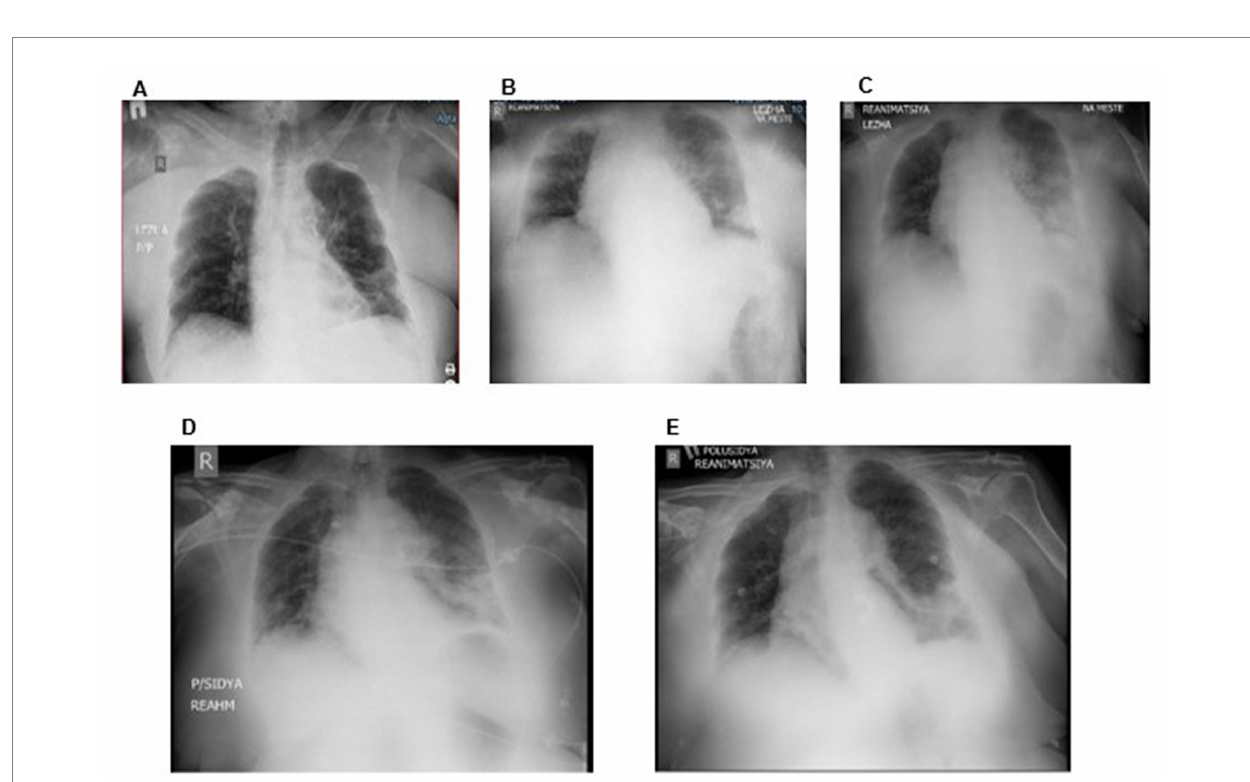
FIGURE 2 Dynamics of chest X-ray after adding a continuous infusion of meropenem: CXR on the 1st day (A) , CXR on the 2nd day (B) , CXR on the 3rd day (C) , CXR on the 5th day (D) , and CXR after 6 days of continuous infusion of meropenem (11th day of hospitalization) (E)